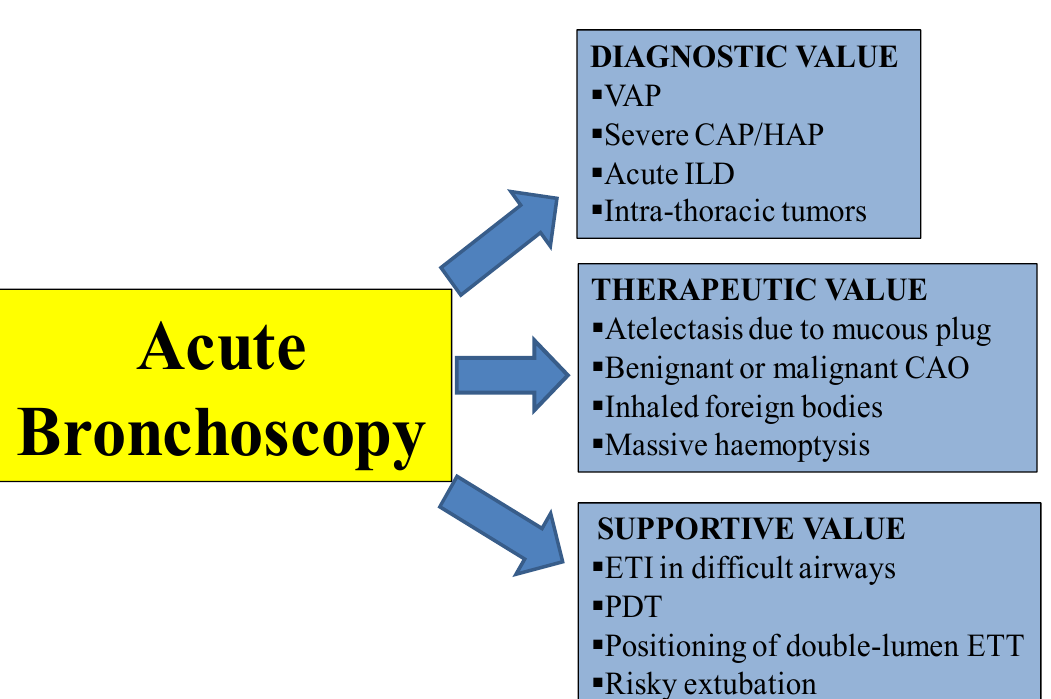
Figure 1. Clinical “added” value and indications of acute bronchoscopy. CAP = Community acquired pneumonia; CAO = central airway obstruction; ETI = Endotracheal intubation; HAP = Hospital acquired pneumonia; ILD = Interstitial lung disease; PDT = percutaneous dilatational tracheostomy; VAP = ventilator associated pneumonia.